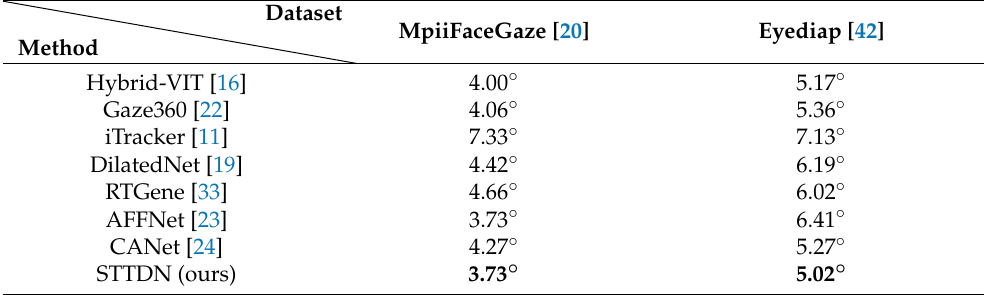
Table 1. Angular error of STTDN and comparison methods on the MpiiFaceGaze [20] and Eye- diap [42] datasets.